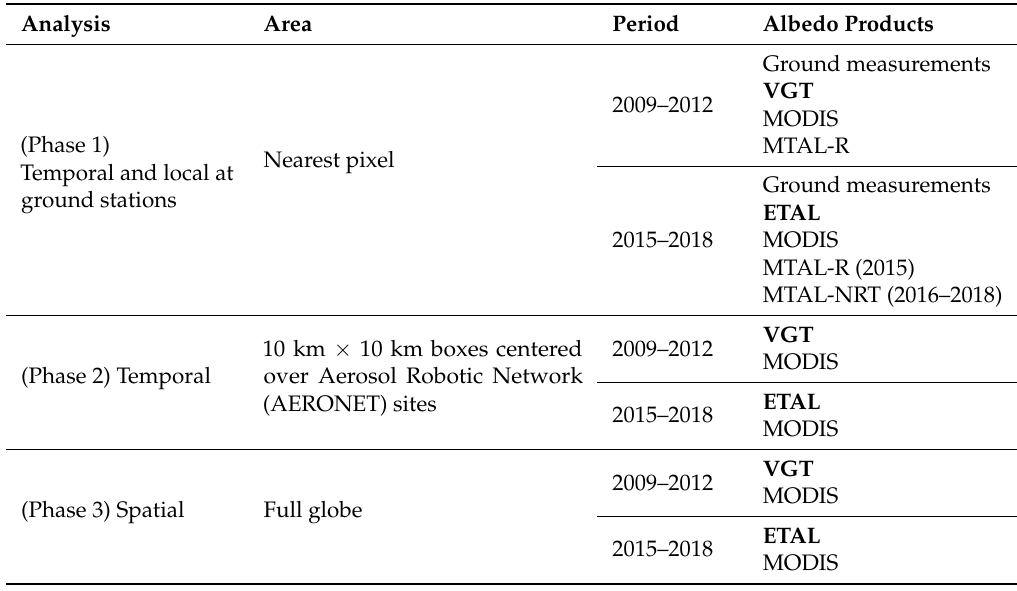
Table 4. Evaluation